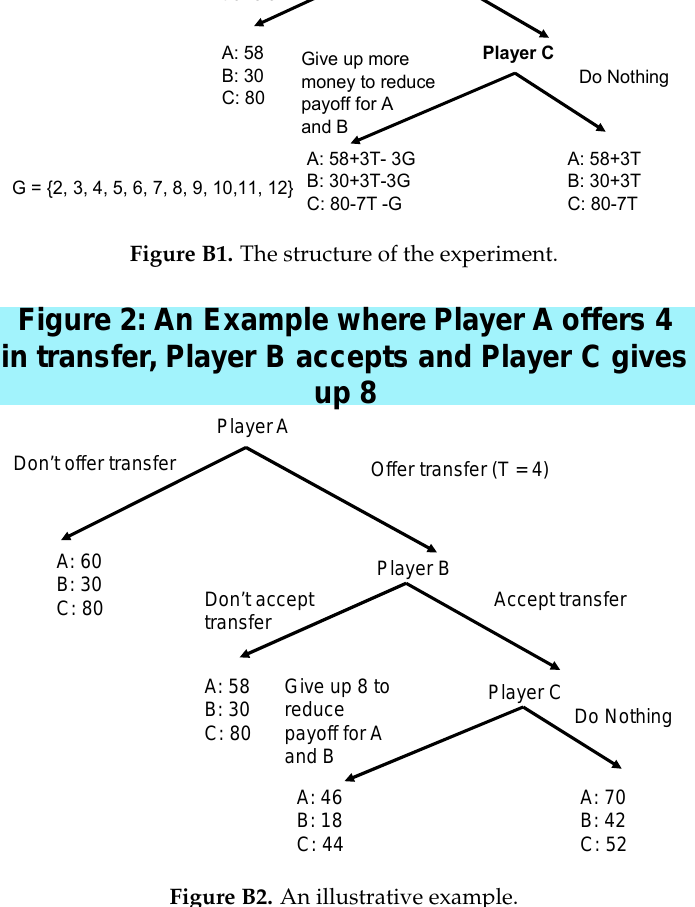
Figure B2. An illustrative example.